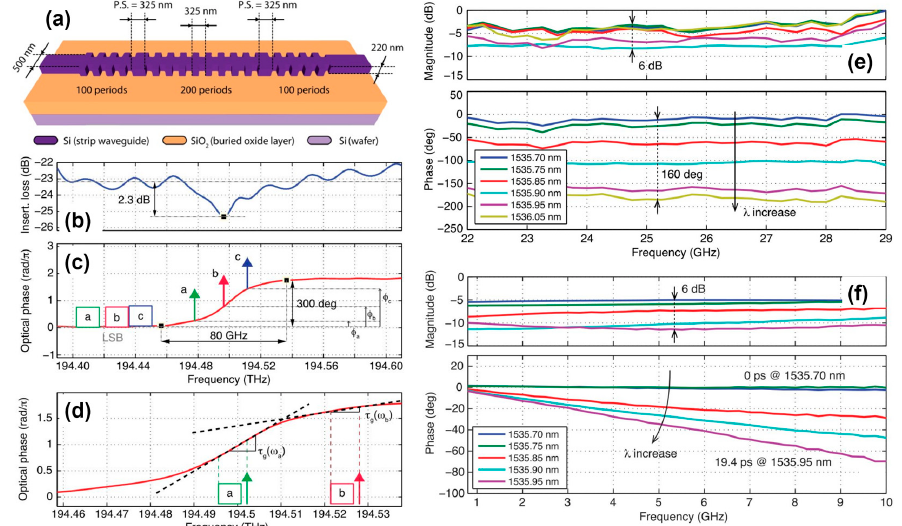
( b ) DPS-WBG magnitude response, ( c ) Operation as phase shifter (PS), and ( d ) true time delay (TTD). ( e ) Complex (magnitude and phase) RF response for different phase shift values. ( f ) Complex (magnitude and phase) RF response for di ff erent true time delay values. Courtesy of Maurizio Burla [87].